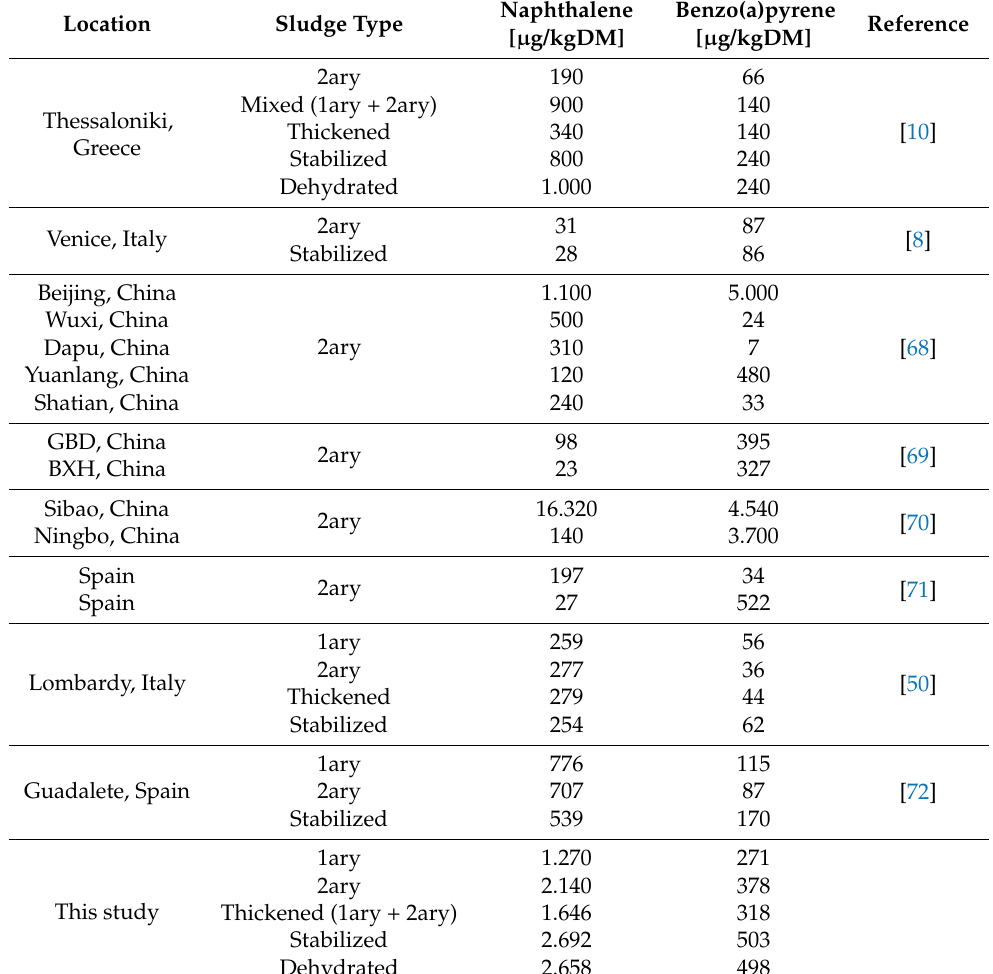
Table 6. Summary of PAHs presence in sludge/biosolids from